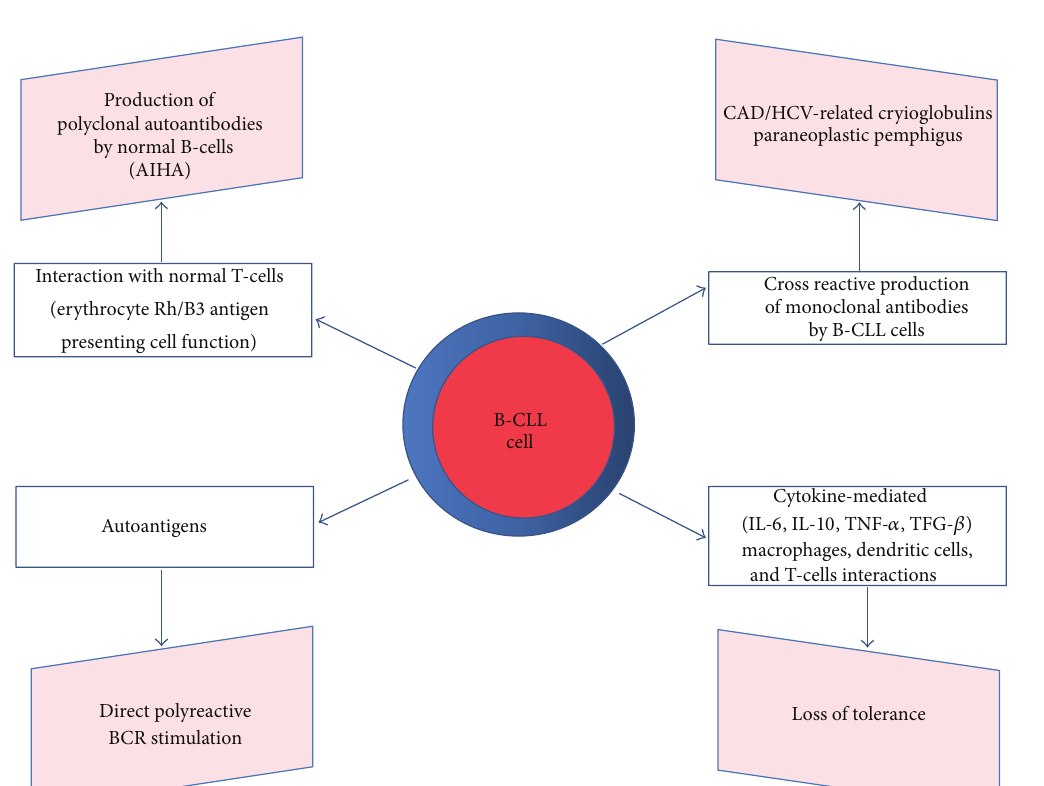
Figure 1: Four main hypotheses of the CLL-associated autoimmune disorders pathogenesis. (1) CLL B-cells may act as either antigen presenting cells and processing cells of red blood cells (RBCs), thus inducing a T-cell response and, in turn, the activation of resting B- cells with the production of polyclonal antibodies against erythrocytes and, ultimately, hemolysis. (2) CLL B-cells may more rarely act as effector cells secreting pathological monoclonal autoantibodies. This is thought to happen in cold agglutinin disease (CAD), hepatitis C virus (HCV)-relatedcryoglobulins,andparaneoplasticpemphigus.(3)AutoantigensmaystimulateB-CLLcellsbymeansoftheirpolyreactiveBcell receptor (BCR). (4) Inhibitory cytokines, such as interleukin (IL)-6, IL-10, tumor necrosis factor (TNF), and tumor growth factor (TGF)- 𝛽 , may be produced by B-CLL cells resulting in the loss of